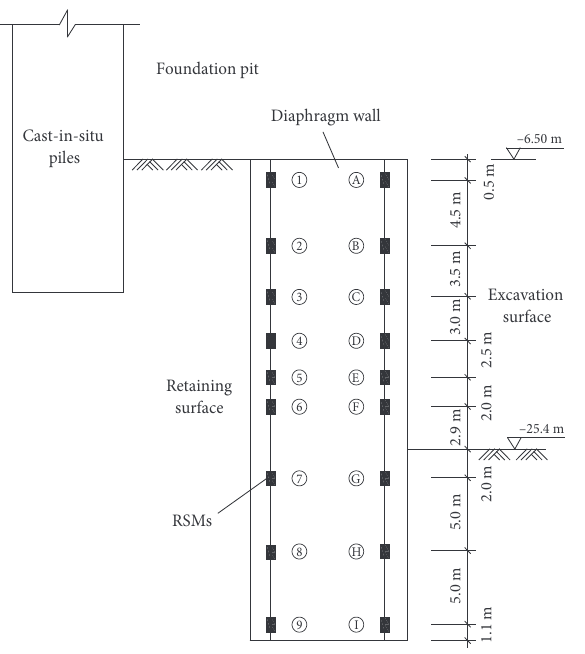
Figure 5. Schematic of installation position of rebar stress meters